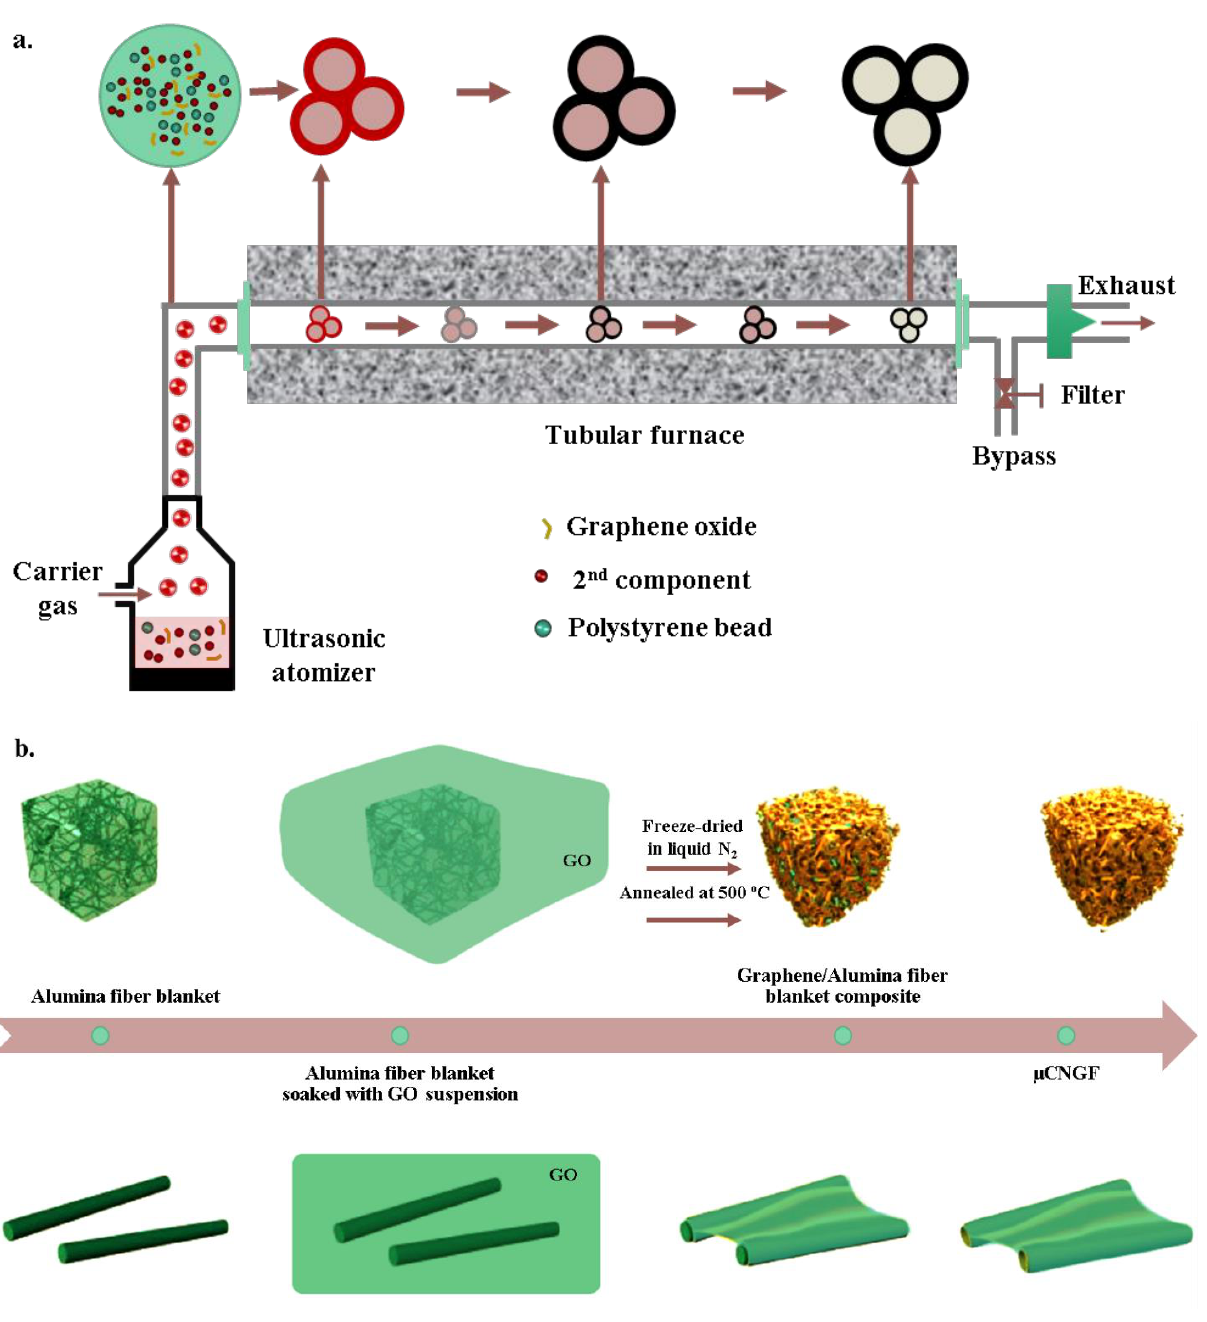
Figure 6. ( a ) rGO capsule production experimentally. Adapted with permission from Ref. [61]. Copyright © 2012, Royal Society of Chemistry. ( b ) The procedures involved in producing mCNGFs. Adapted with permission from Ref. [62]. Copyright © 2014, Royal Society of Chemistry.